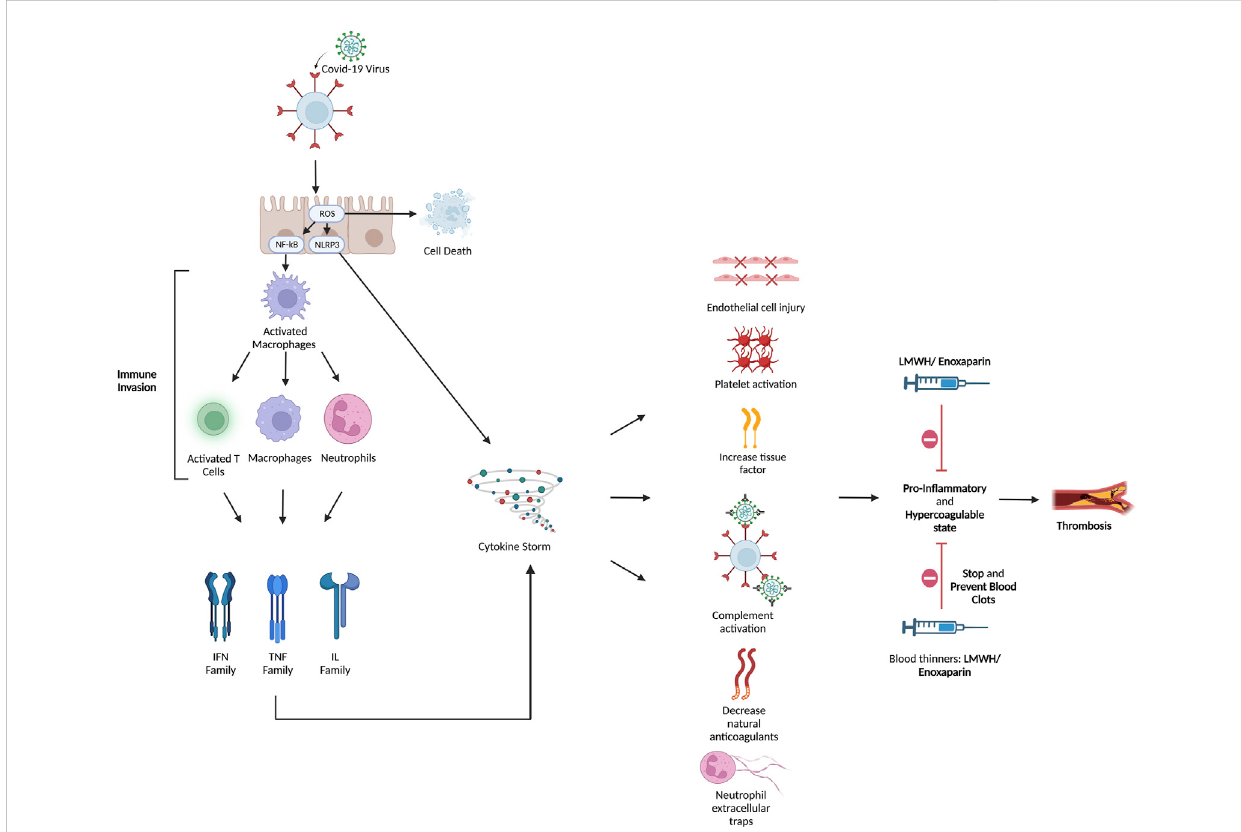
FIGURE 2 Hyperin fl ammatory and hypercoagulable conditions were brought on by COVID-19. Although the pathophysiology of the coagulopathy caused by COVID-19 has not yet been fully understood, it has been suggested that immunological dysregulation, hyperin fl ammation, and thrombosis interact. The SARS-CoV-2 virus enters the cell through endocytosis by interacting with the ACE-2 receptor through its spike protein. Both endothelial and respiratory cells highly express ACE-2. The virus releases its genetic material inside the cell and uses its cellular machinery for replication. There are two proposed methods by which the viral effect occurs: (Zhu et al., 2020) direct viral insult and (Moschonas and Tselepis, 2021) indirect cytokine-mediated injury. The host cell suffers direct harm and undergoes apoptosis as a result of the viral cytopathic impact. In turn, platelet activation and aggregation are brought on by endothelial injury. The virus also causessevere in fl ammation and immunological dysregulation atthe same time. In order to produce pro- in fl ammatory cytokines including IL-1, IL-2, IL-6, IL-10, IL-17, IL-18, and TNF-, it suppresses lymphocytic activity and activates macrophages and polymorphonuclear cells. This results in a cytokine storm in cases of severe infection. Cytokines and the damaged epithelium cause TF synthesis, VWF release, and triggers the coagulation cascade. The cytokine storm also leads to complement system activation, which causes coagulopathy by causing plateletstobecomeactiveandboostingthesynthesisof fi brinandthrombin.ThecytokinestormislinkedtoNETs,whichinturnboostVWFandTFactivity and inhibits thrombomodulin and tissue factor inhibitor, leading to in fl ammation and microvascular thrombosis. Laboratory results are typically notable for a combination of prolonged prothrombin time, normal to mildly prolonged activated partial thromboplastin time, thrombocytopenia, high D-dimer level, fi brinogen, fi brinogen degradation products, VFW, plasminogen, protein C, and factor VIII. Clinically, both the venous and arterial systems are impacted by the hyperin fl ammatory response and endothelial dysfunction. Here is where heparin and LMWH serve their effect to stop and prevent blot clotting. ACE-2: angiotensin converting enzyme-2; IL: Interleukin; VWF: von Willebrand factor; NET: neutrophil extracellular traps; TF: Tissue